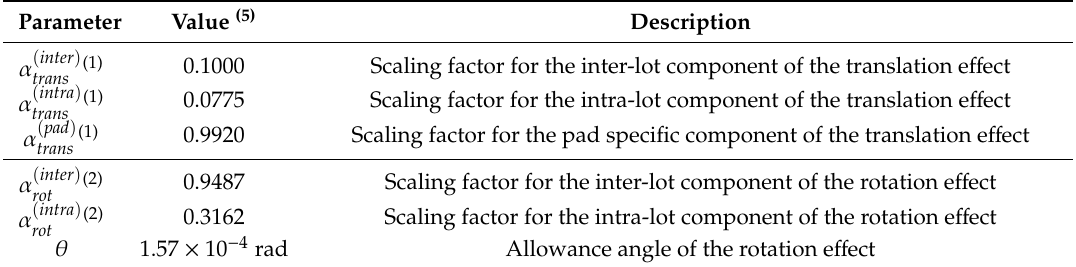
Table 2. Tuning parameters in the AGV module and the values used in this